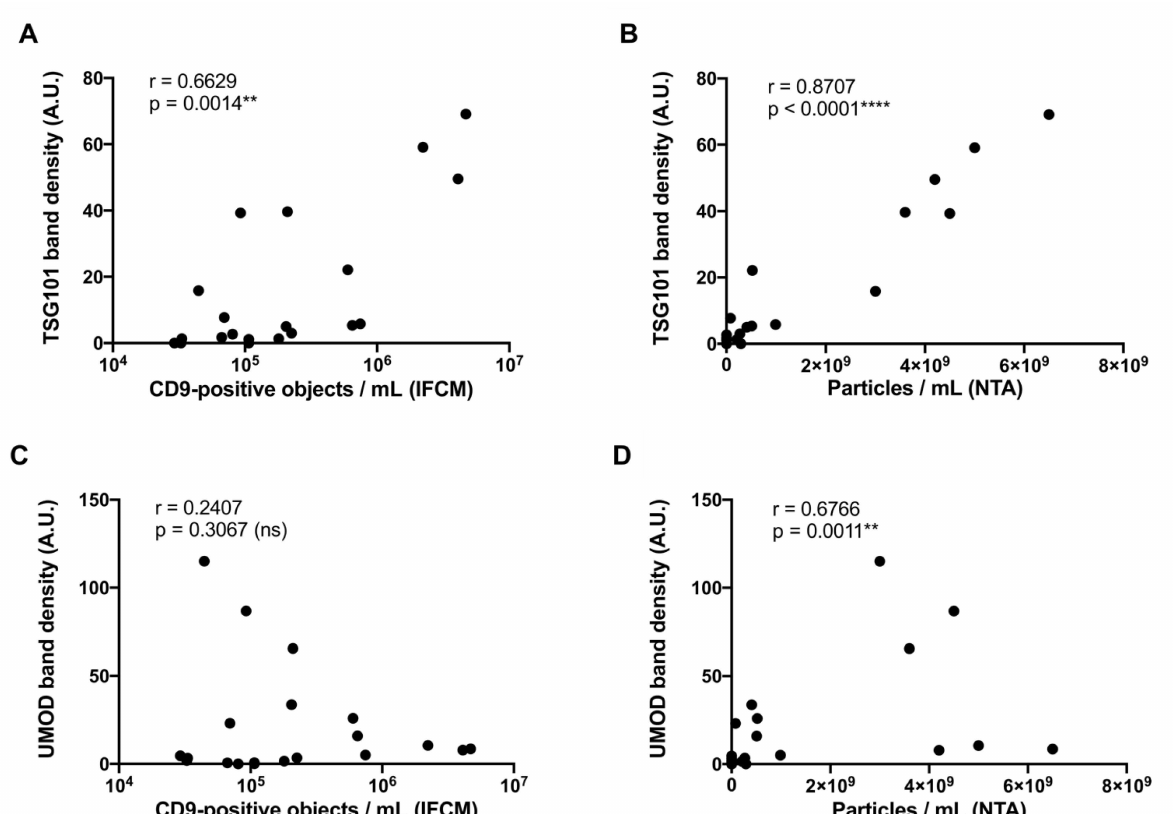
Figure 6. IFCM but not traditional NTA specifically detects EVs for the evaluation of EV preparation methods. Correlation analyses of acquired Western blot band intensities (TSG101 and UMOD) with CD9 + object numbers as determined by IFCM or with average particle numbers as determined by NTA (n = 20) applying Spearman’s correlation coefficient analysis. ( A ) Correlation analysis of CD9 + objects and TSG101 band intensities. ( B ) Correlation analysis of particle numbers and TSG101 band intensities. ( C ) Correlation analysis of CD9 + objects and UMOD band intensities. ( D ) Correlation analysis of particle numbers and UMOD band intensities. ** p ≤ 0.01, **** p ≤